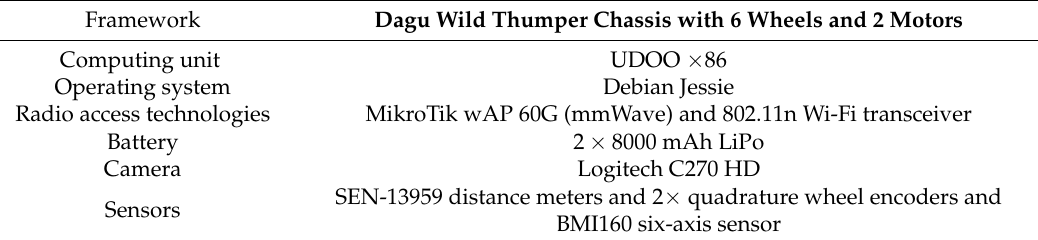
Table 2. Technical specifications and features of multi-RAT robotic platform.